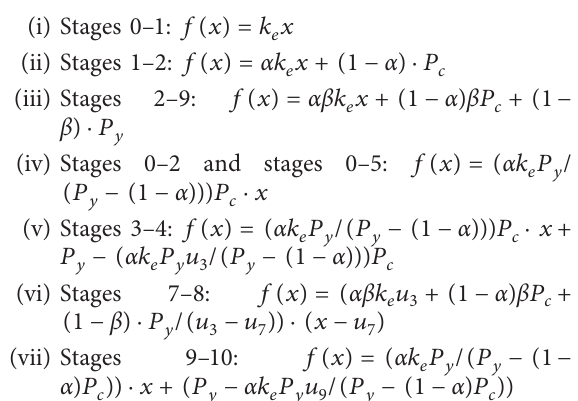
Figure 2: Degenerate trilinear